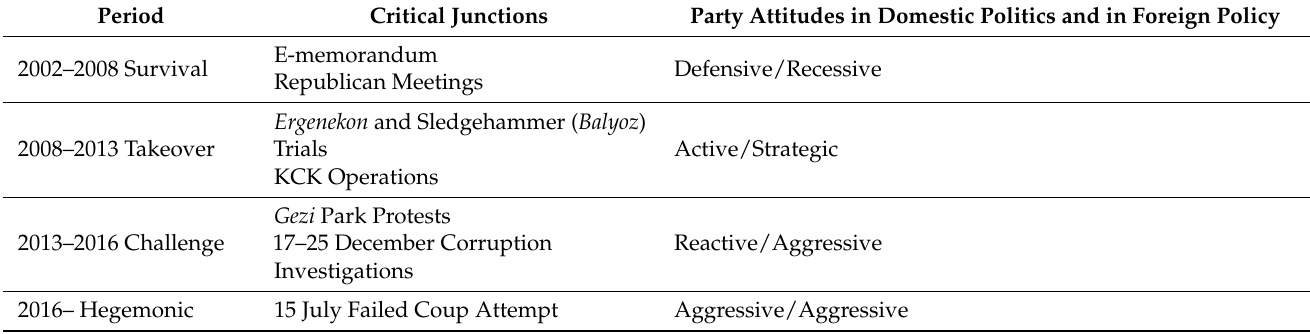
Table 1. Turkey’s AKP’s Political Journey and its Attitudes in Domestic and Foreign Policy.